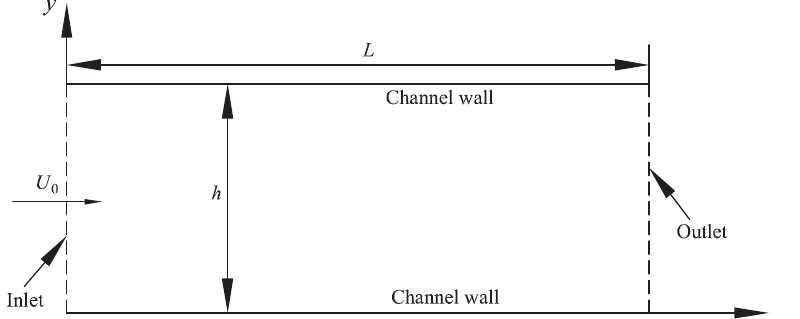
Figure 1. Schematic of power-law fluid flow in a channel.